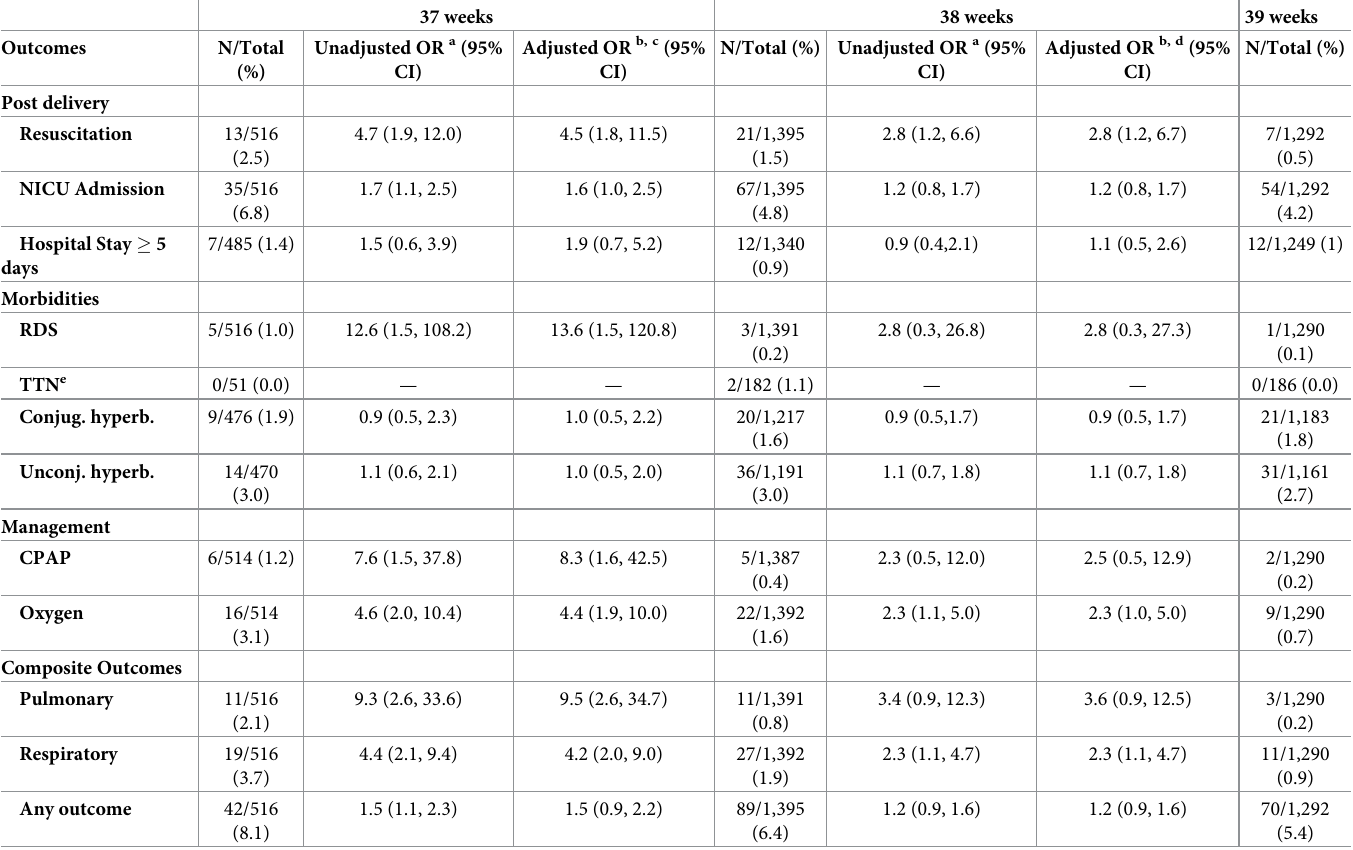
Table 2. Unadjusted and adjusted ORs for adverse neonatal outcomes at 37 and 38 compared to 39 weeks of gestation among women with primary CS. 37